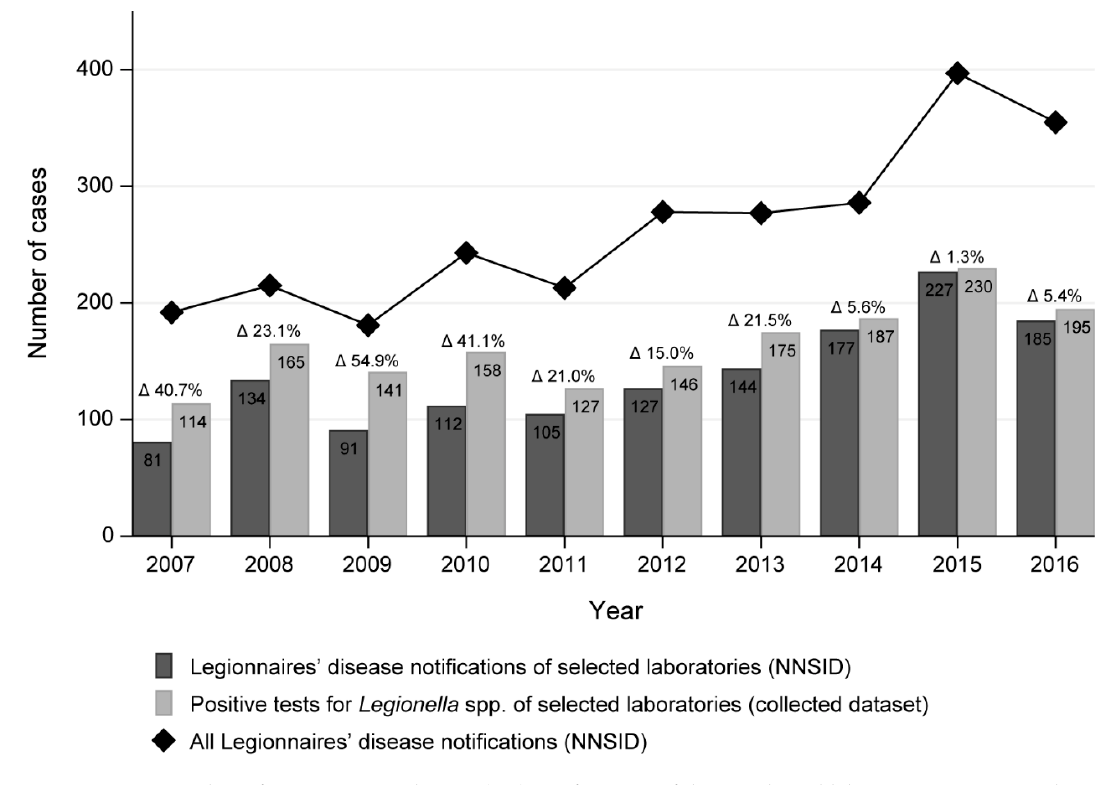
Figure 1. Number of Legionnaires’ disease (LD) notifications of the 14 selected laboratories as reported in the Swiss National Notification System for Infectious Diseases (NNSID) and the number of positive tests of the selected laboratories, as well as the total number of LD notifications reported in the NNSID per year, 2007–2016, Switzerland. The figures in the bars correspond to the number of observations; the relative difference between them is denoted as the percentages above the bars.